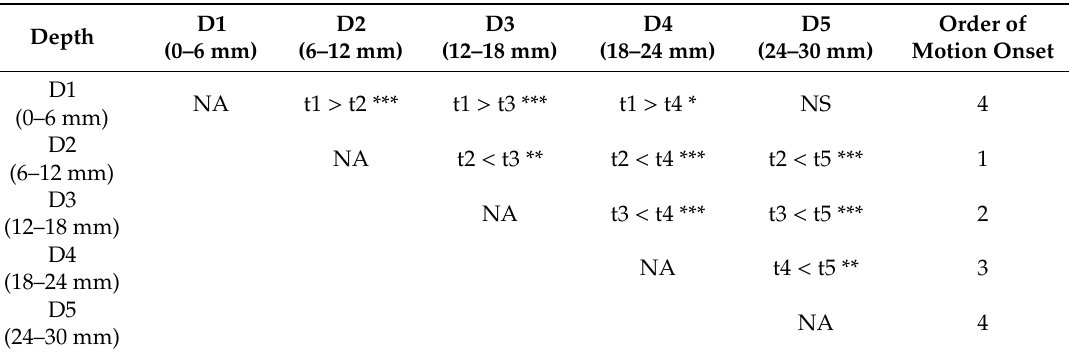
Table 2. Pairwise comparison between onset time at different proximal–distal positions (along the width of the image shown in Figure 3A, with W1 as the most distal location and W5 as the most proximal location. * p < 0.05, NA: not applicable, NS: no significant difference. p -value corrected using Bonferroni correction.